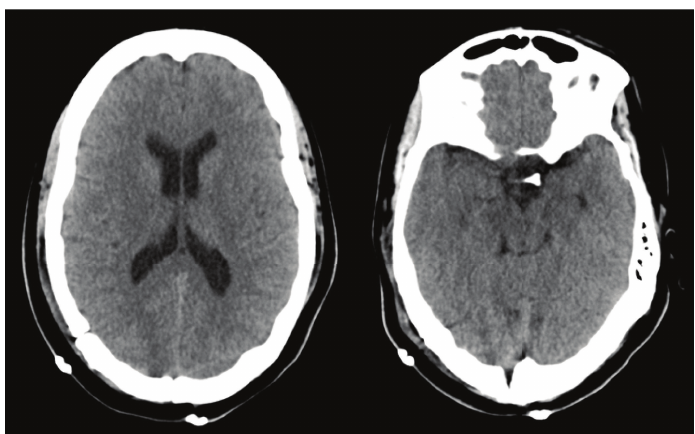
Figure 4: Postoperative CT scan done 2 weeks after surgery showing complete resolution of pneumocephalus.